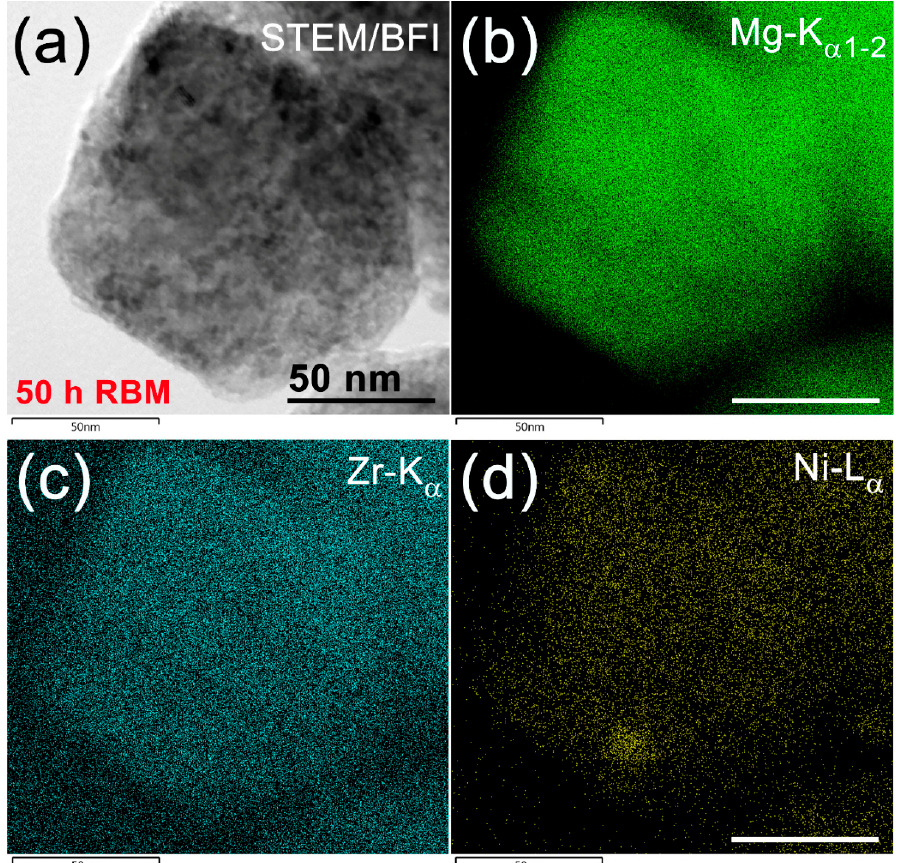
Figure 6. ( a ) Scanning transmission electron microscope (STEM)/BFI image of Mg powders milled under pressurized hydrogen for 50 h, using Zr 2 Ni balls-milling media. The X-ray elemental mapping corresponding to Mg ‐ K 1 ‐ 2 , Zr ‐ K and Ni ‐ L are displayed in ( b ), ( c ) and ( d ), respectively.